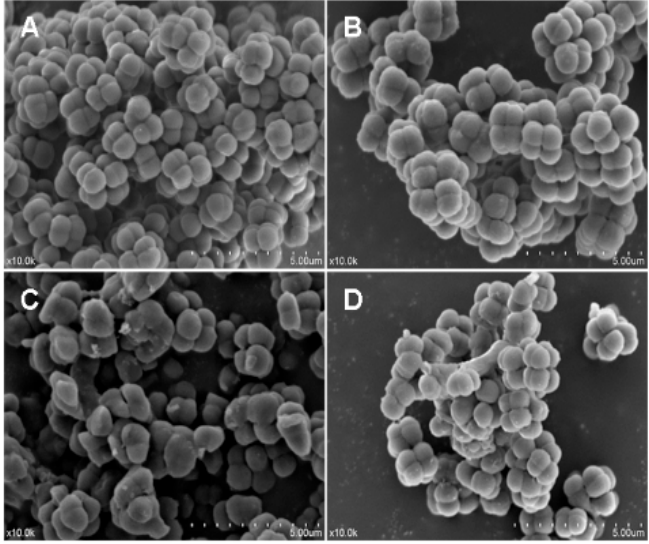
Figure 8. Morphological changes of S. aureus cells membrane by scanning electron microscopy. ( A ), ( B ), ( C ), and ( D ) are the image graphs of S. aureus cells treated with PBS buffer, LGH2 at 0.5 × MIC, LGH2 at 1 × MIC, and LGH2 at 2 × MIC, respectively.